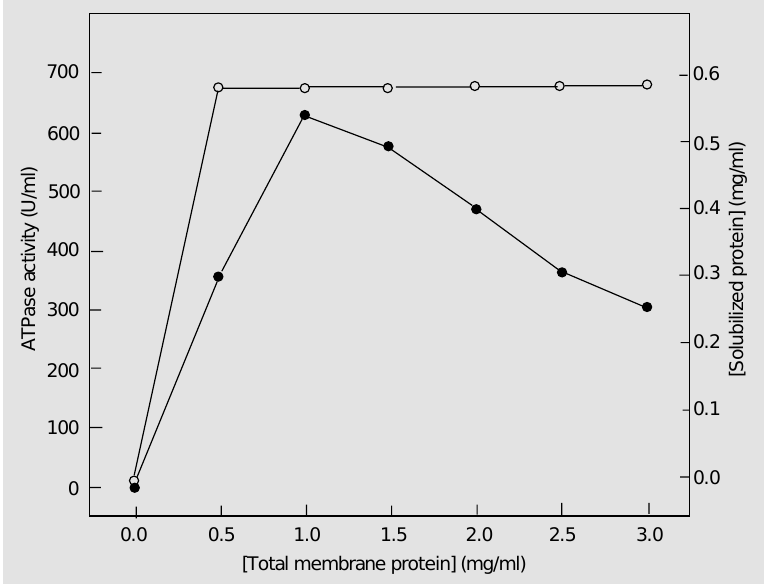
Figure 2. Solubilization of membrane-bound Na,K-ATPase with 1 mg/ml C 12 E 8 . Aliquots containing different concentrations of membrane-bound Na,K-ATPase in 20 mM imidazole buffer, pH 6.8, containing 250 mM sucrose, 6 mM Tris and 6 mM EDTA were mixed at 4 (cid:1) C with 1 mg/ml C 12 E 8 and centrifuged for 1.5 h at 100,000 g using a Hitachi (Model 55P-72) centrifuge. The supernatant was assayed for ATPase activity (filled circles) and solubilized protein (open circles). ATPase, adenosine